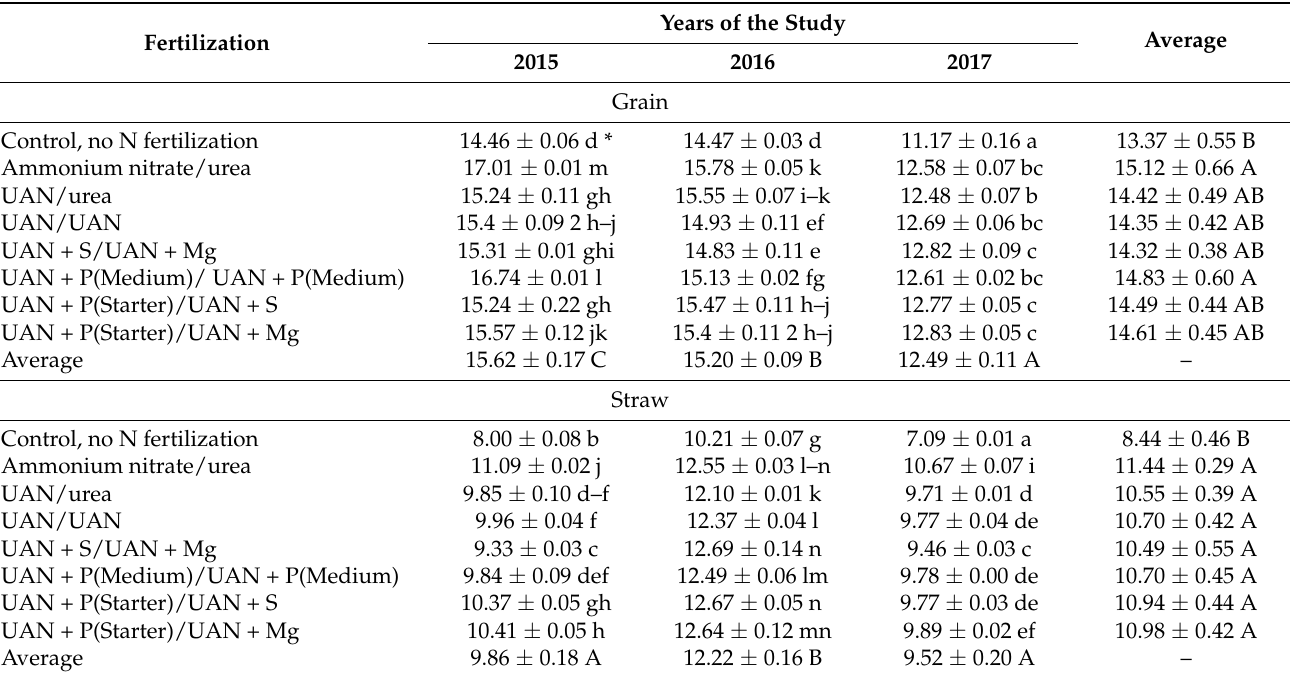
Table 4. Nitrogen content (g kg − 1 d.m.) in maize grain and straw (mean ±